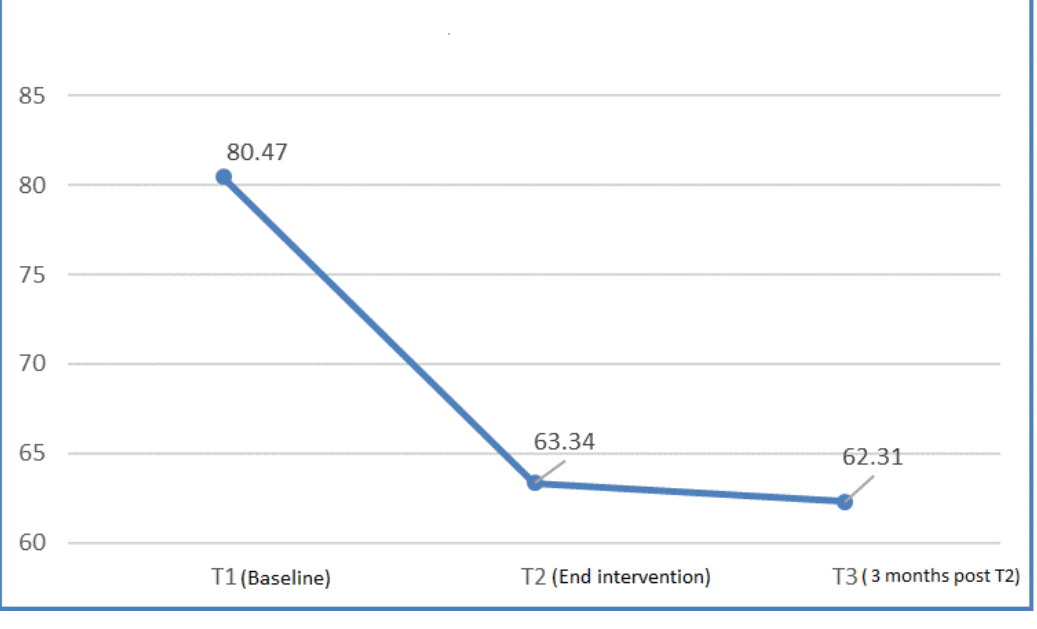
Figure 4. Changes in mean hemoglobin A 1c (%).